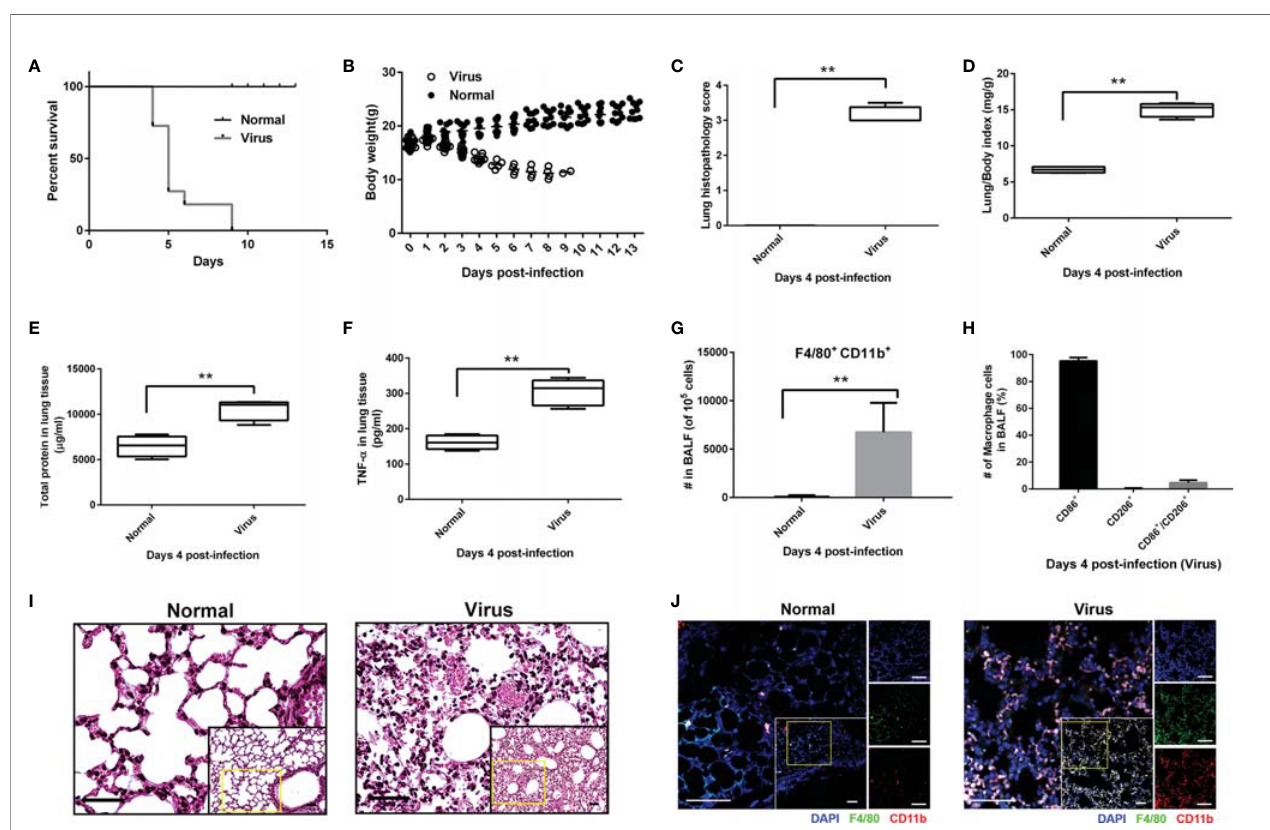
FIGURE 1 | High mortality and macrophage-related overactivation of in fl ammatory responses in infected mice. Mice (n = 6 or 10, per group) were infected with freshly prepared in fl uenza virus A/FM/1/47 (H1N1) strain. Mice (n = 10, per group) and monitored daily for survival and body weight. For lung histopathology, the mice (n = 6, per group) were euthanized with 10% phenobarbital to harvest the whole lungs on day 4 post-infection. (A) Percentage survival. Data below individual survival curves represent the number of survivors/total number of mice. (B) Bodyweight. Mice were weighed every day. (C) Lung histopathology score. Data were calculated by evaluating the histopathological severity of the analyzed sections of each lung (six separate random fi elds per tissue section); the scores were assigned as: normal = 0; minor = 1; mild= 2; intermediate = 3; and severe = 4. (D) Lung/body index was calculated as follows: whole lung weight (mg)/body weight. (E, F) The right lobes of the mice were homogenized to quantify the total protein (E) and in fl ammatory cytokine TNF- a (F) . (G-H) Flow cytometric analysis of the macrophage number and phenotype in BALF; macrophages (CD11b and F4/80 positive cells), M1 polarized macrophages (CD11b, F4/80 and CD86 triple-positive cells), and M2 polarized macrophages (CD11b, F4/80 and CD206 triple-positive cells). Mean ± SD from at least three independent experiments are shown. ** p < 0.01. (I) H&E staining of the lung tissues. Scale bar: 40 m m. (J) Immuno fl uorescence histochemical staining of the lung tissues. Scale bar: 50 m